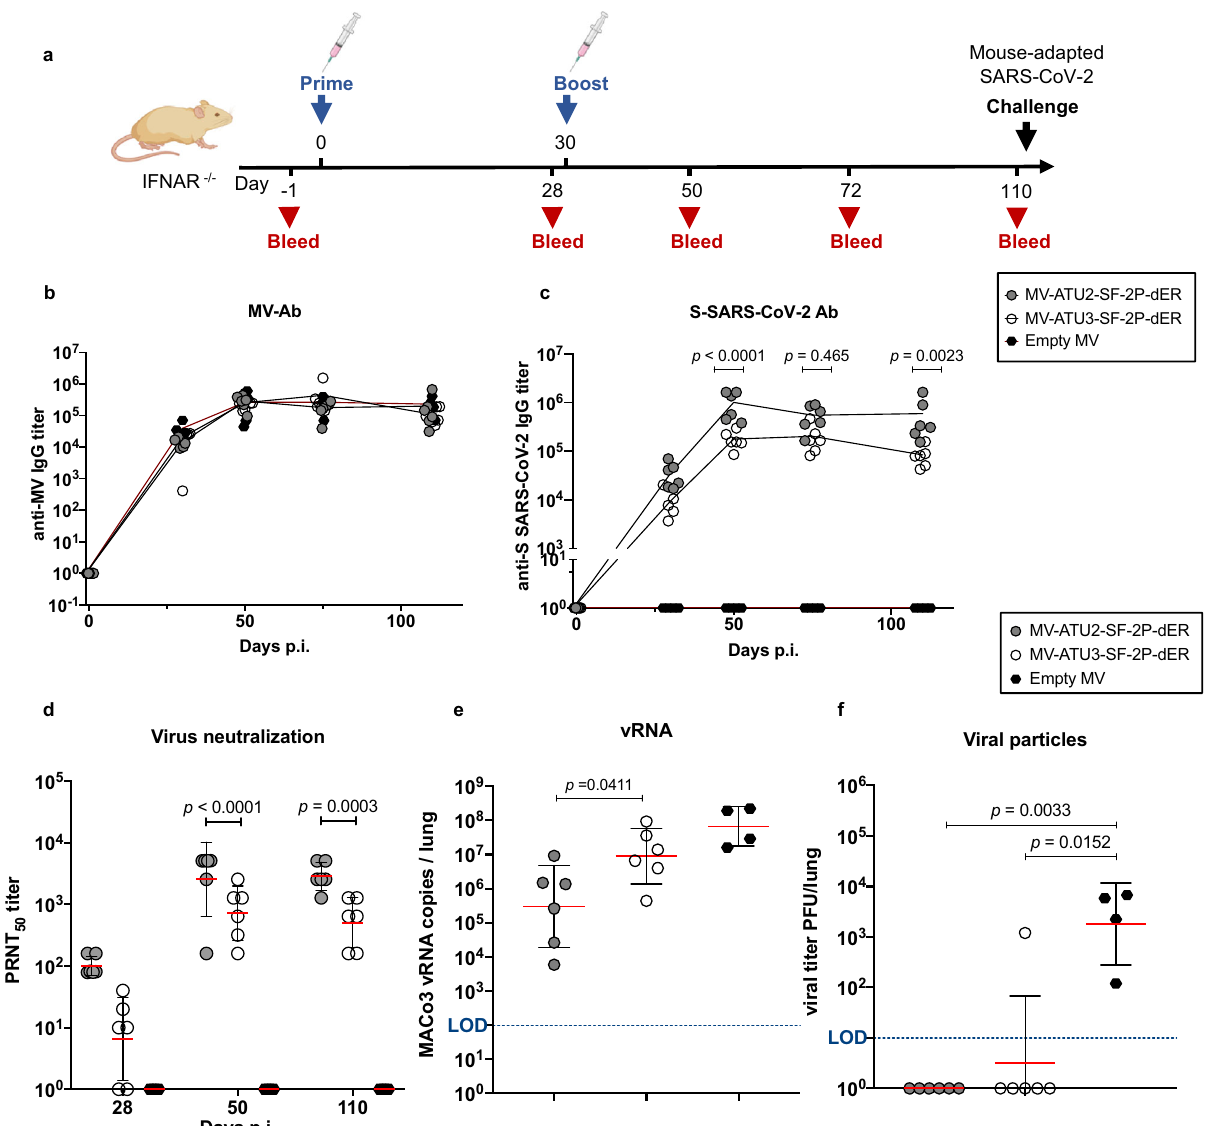
Fig. 6 Persistence of neutralizing antibodies and immune protection. a Immunization and challenge schedule for IFNAR − / − mice ( n = 6 and n = 4 in the control group; Empty MV). Animals were immunized interperitoneally by homologous prime-boost at days 0 and 28. Sera were collected at days 52, 72, and 110. Animals were challenged on day 110 by intranasal inoculation of mouse-adapted SARS-CoV-2 virus (MACo3) at 1.5 × 10 5 PFU. Sera were assessed for levels of speci fi c antibodies against b MV and c SARS-CoV-2 S. d Neutralizing antibody responses against SARS-CoV-2 virus, expressed as 50% plaque reduction neutralization test (PRNT 50 ) titers. e SARS-CoV-2 viral RNA copies detected by RT-qPCR in homogenized lungs of challenged animals, calculated as copies/lung. f Titer of infectious viral particles recovered from the homogenized lung of the immunized animals expressed as PFU/lung. Dotted blue line indicates the limit of detection (LOD). Data are represented as geometric means with line and error bars indicating ±geometric SD. Statistical signi fi cance was determined by ( c , d ) a two-way ANOVA with Tukey ’ s multiple comparisons test and ( e ) two-tailed the Mann – Whitney test ( f ) Kruskal – Wallis one- way ANOVA test with Dunn ’ s multiple comparison